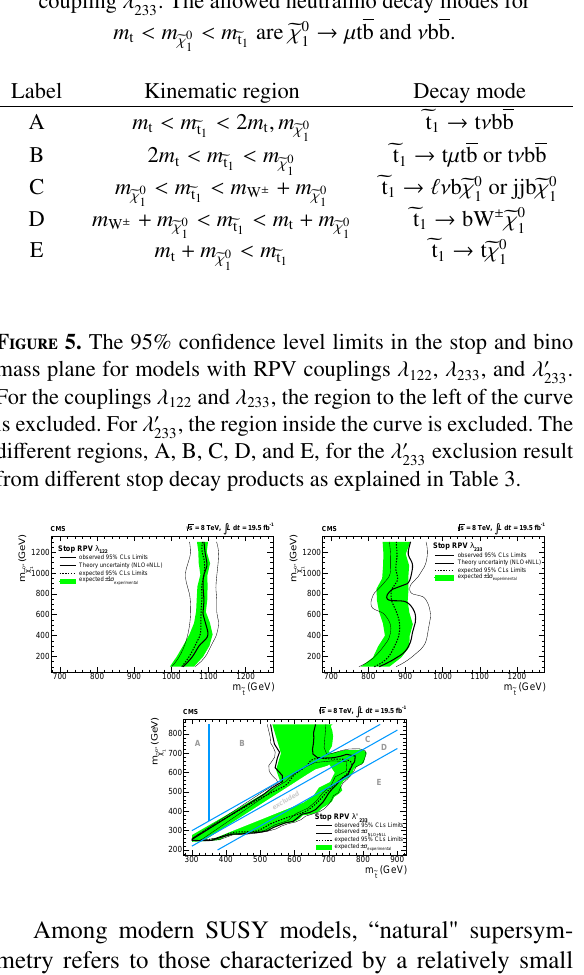
Table 3. Kinematically allowed stop decay modes with RPV coupling λ (cid:48) . The allowed neutralino decay modes for 233